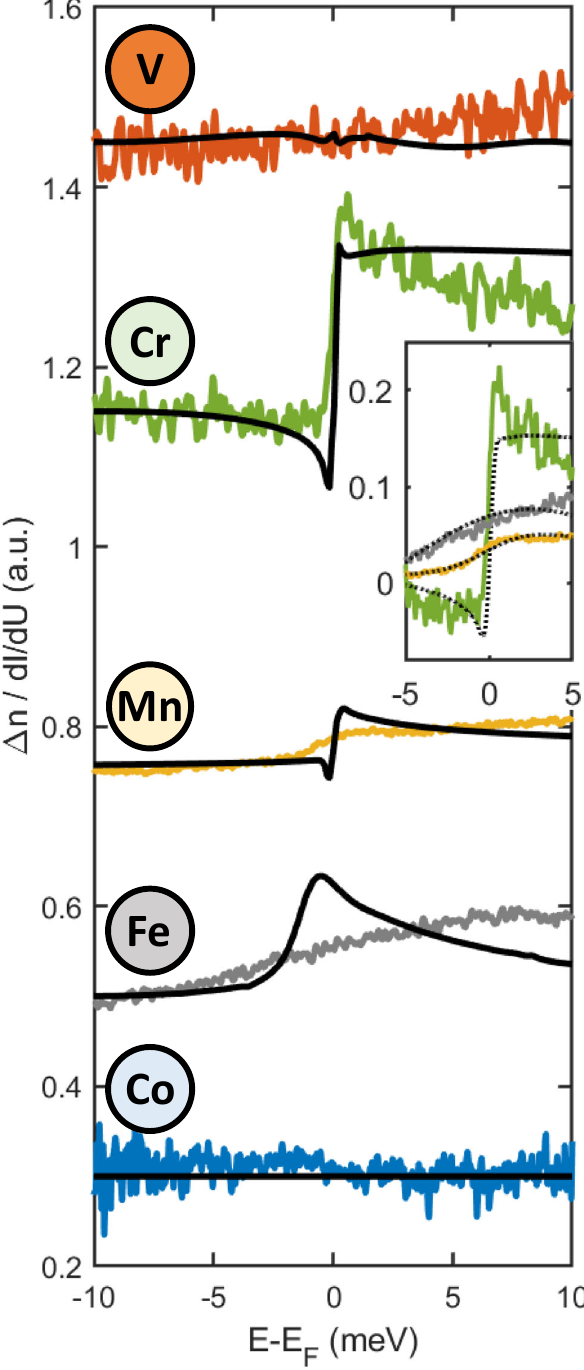
Fig. 5 Spin-excitation spectroscopy. For all adatoms, the experimentally obtained spectra are reported as solid lines following, for each element, the same color-coding scheme used across the manuscript. To exclude spurious effects related to the use of different microtips, all spectra are normalized to the substrate. To drive the system into a metallic state, a magnetic fi eld has been applied perpendicular to the sample surface. All spectra are overlapped with the theoretically calculated spin-excitation spectra (solid black line). The inset shows the theoretical spectra with an arti fi cial Gaussian broadening of 0.20 meV, 1.98 meV, and 7.78 meV for Cr, Mn, and Fe, respectively (dashed lines). Stabilization parameters: Cr, Fe, Mn: V = 10 meV, I = 500 pA; V, Co V = 10 meV, I = 1